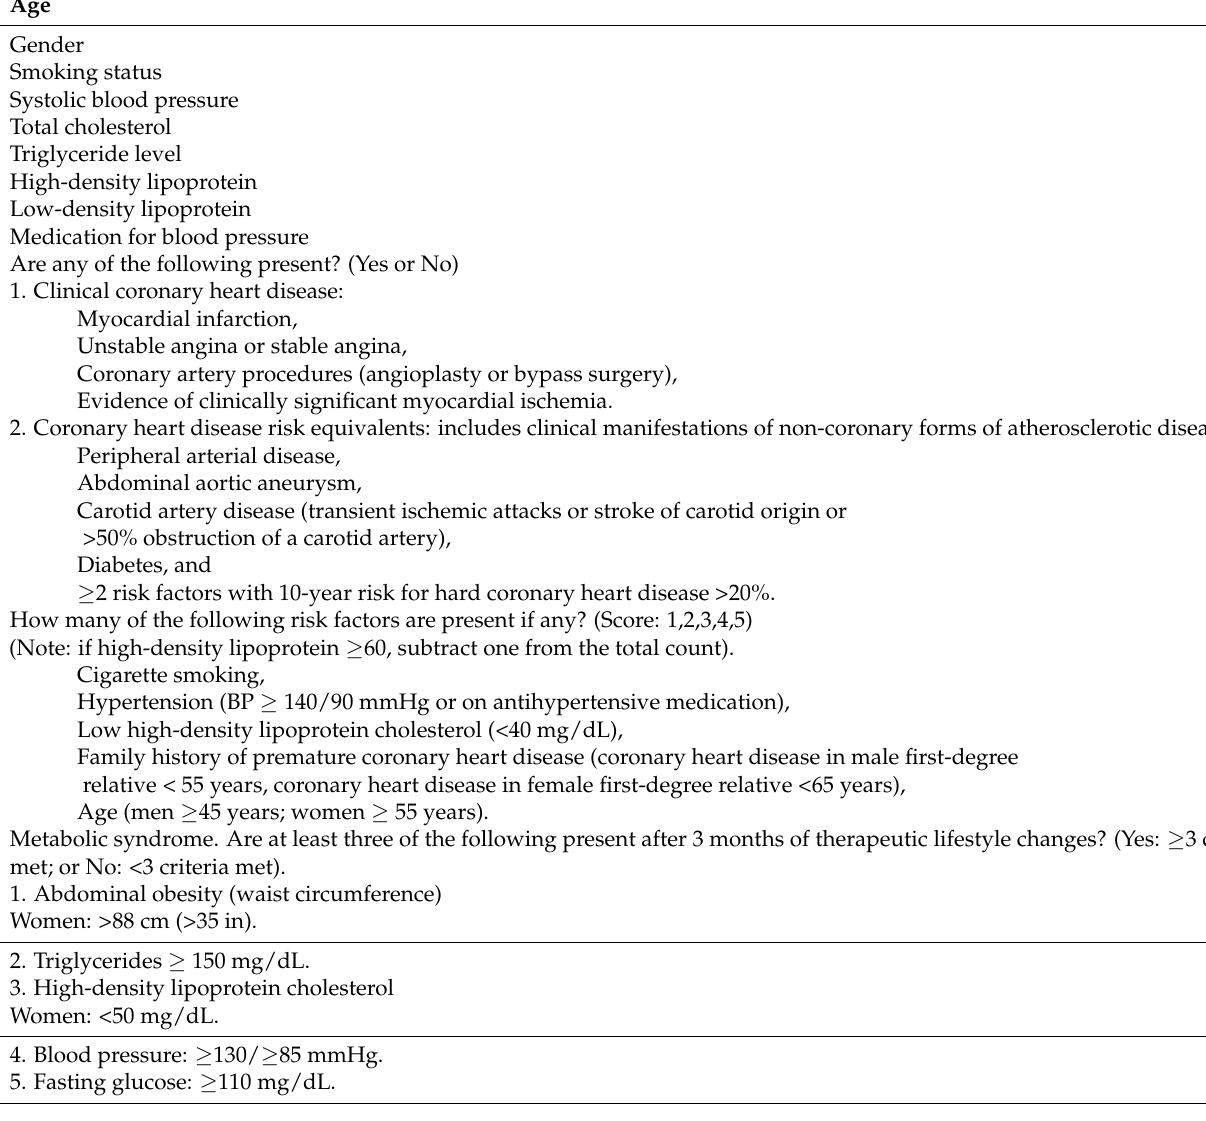
Table 1. Variables used in adult treatment panel (ATP III)